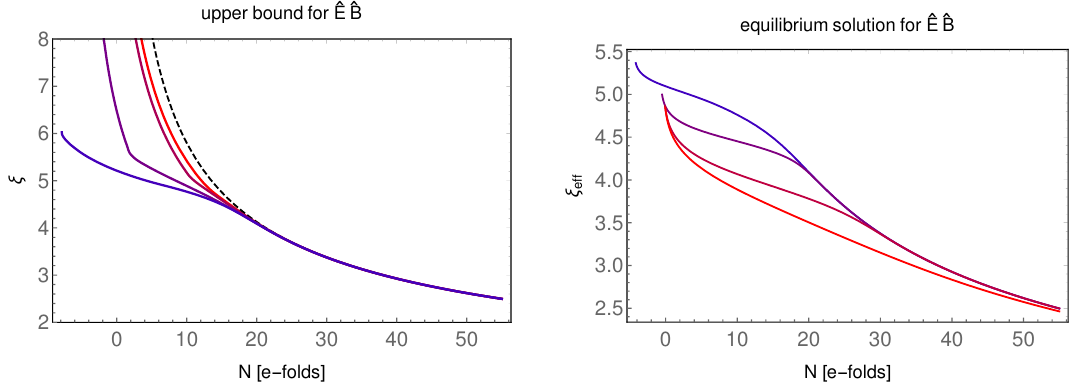
Figure 7 . Evolution of the parameter (cid:24) (proportional to the in(cid:13)aton velocity) for di(cid:11)erent fermion masses. Left panel: upper bound for ^ E ^ B . Right panel: equilibrium solution for ^ E ^ B . Color coding as in (cid:12)gure